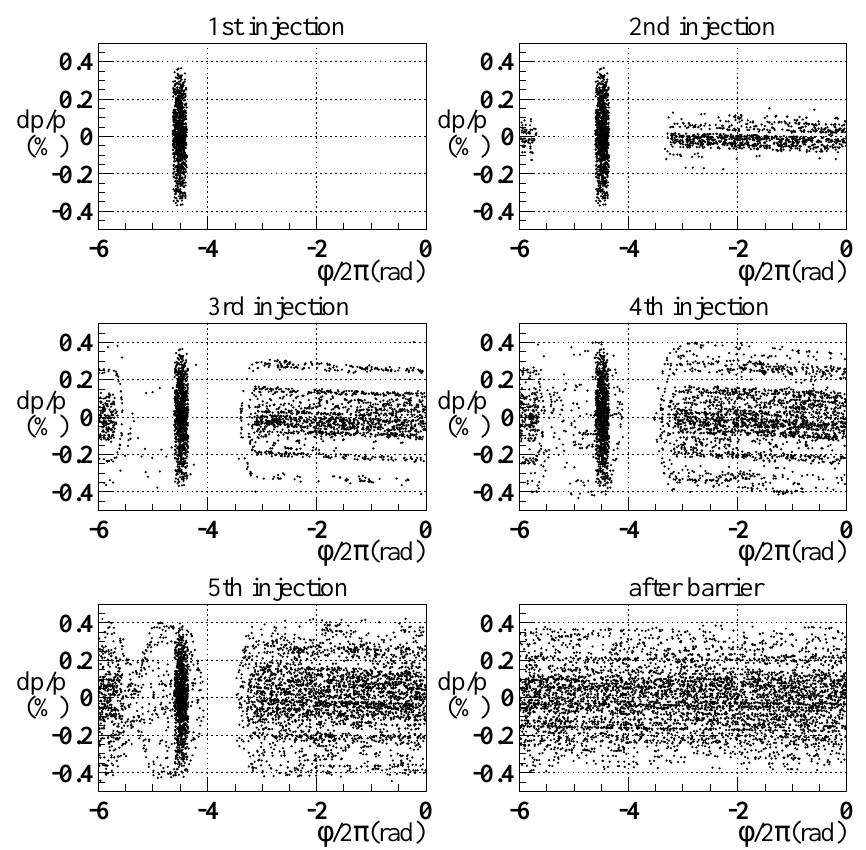
FIG. 13. Phase-space configurations at every injection. The horizontal and vertical coordinates are the rf phase and momentum spread, respectively. The initial bunch width and the momentum spread are 24 ± and 6 0.0038 , respectively. The blowup factor of the longitudinal emittance after five-bunch transfers is 3.2, which is consistent with the experimental result.